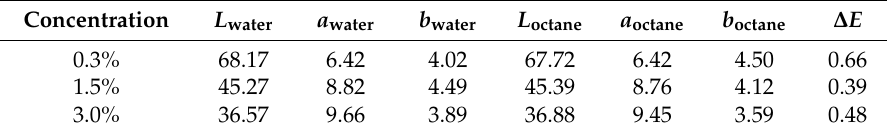
Table 6. ∆ E results. Note: ∆ E denotes colour difference; L is lightness; a refers to the colour component of red and green; and b refers to colour component of yellow and